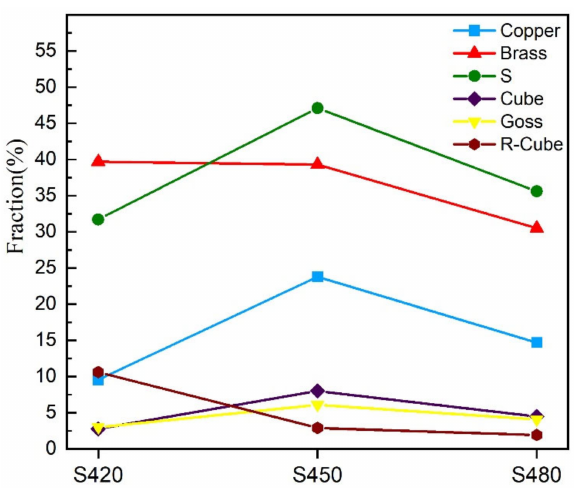
Figure 8. Distribution of crystal orientation of samples at different rolling temperatures after aging treatment: S420 ( a ), S450 ( b ), S480 ( c ).